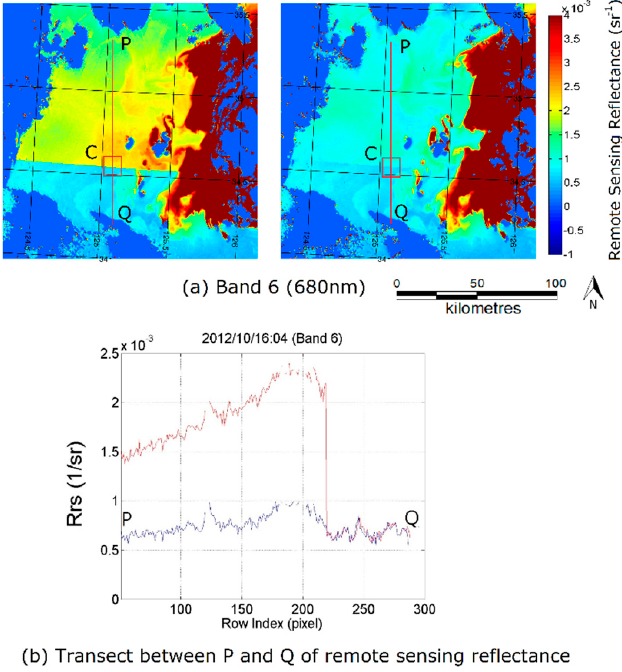
Figure 3. ( a ) Images of GOCI remote sensing reflectance acquired on 16 October 2012 (UTC 04) for Band 6 both before and after the CIDUM correction; ( b ) Profile of remote sensing reflectance along transect PQ.